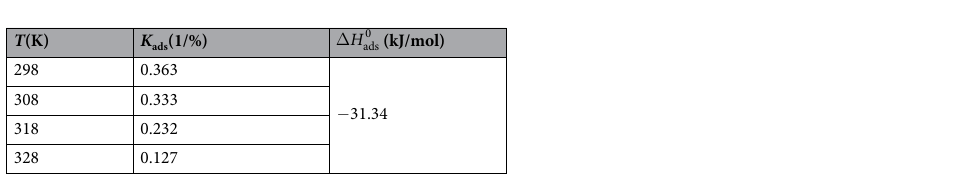
Figure 5. Langmuir isotherm plots for mild steel in 0.5 M H 2 SO 4 solution containing different V/V concentrations of LLE at different temperature.